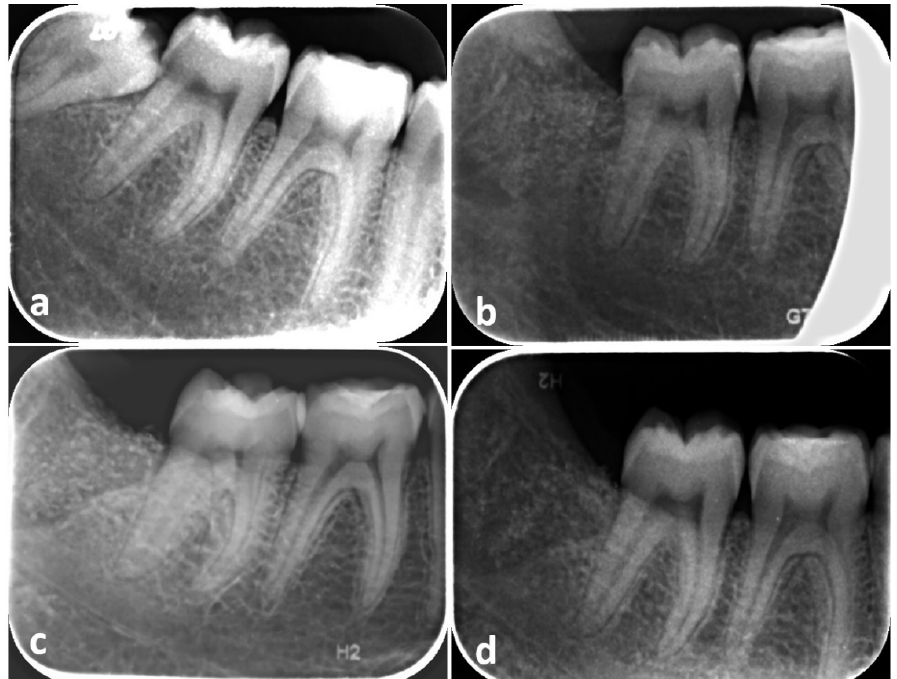
Figure 4. Radiographic images showing the treatment sequence at an experimental site: ( a ) Presur- gical periapical radiograph; ( b ) 15 days, ( c ) 90 days and ( d ) 180 days after socket grafting.